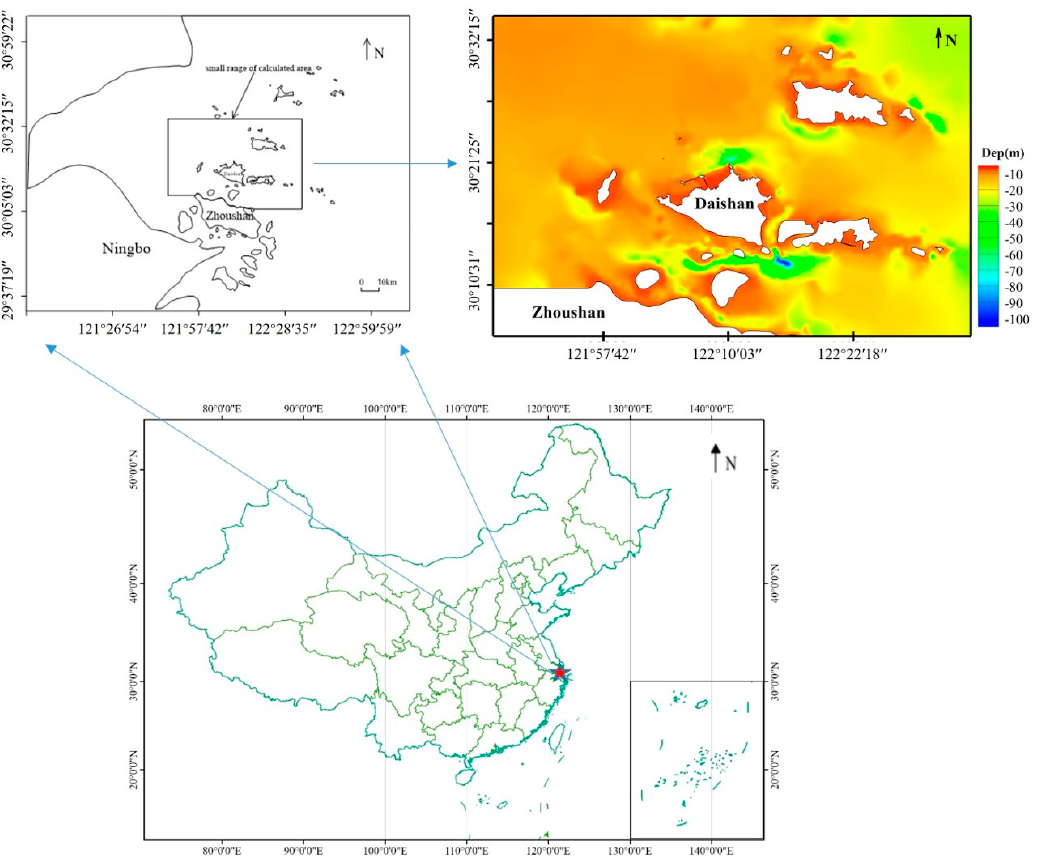
Figure 1. Topographic map of simulated domain.